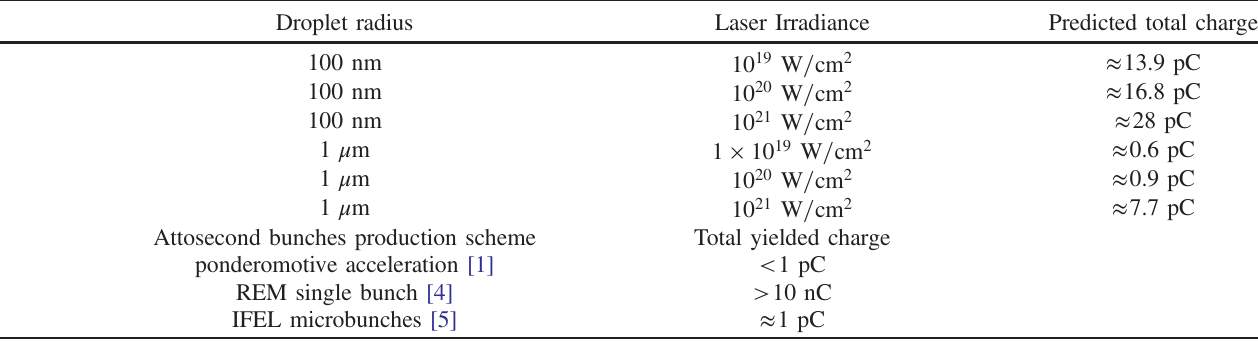
I. Table of electron bunches charge properties as inferred from simulations, for the smallest ( R ¼ 100 nm) and the biggest ( R ¼ 1 μ m) droplet, compared to the performances of other known attosecond bunch generation schemes. Apart from well-known ponderomotive acceleration, quite recent schemes such as REM and IFEL have been considered. The first consists of irradiating normally a solid nanofilm with an ultraintense femtosecond laser pulse, thus accelerating all the electrons in the laser spot simultaneously. The latter is an inverse-free-electron laser process, which can be coupled to a magnetic chicane in order to convert energy modulation into an optically spaced microbunch structure. In this way, stable attosecond electron bunches trains are